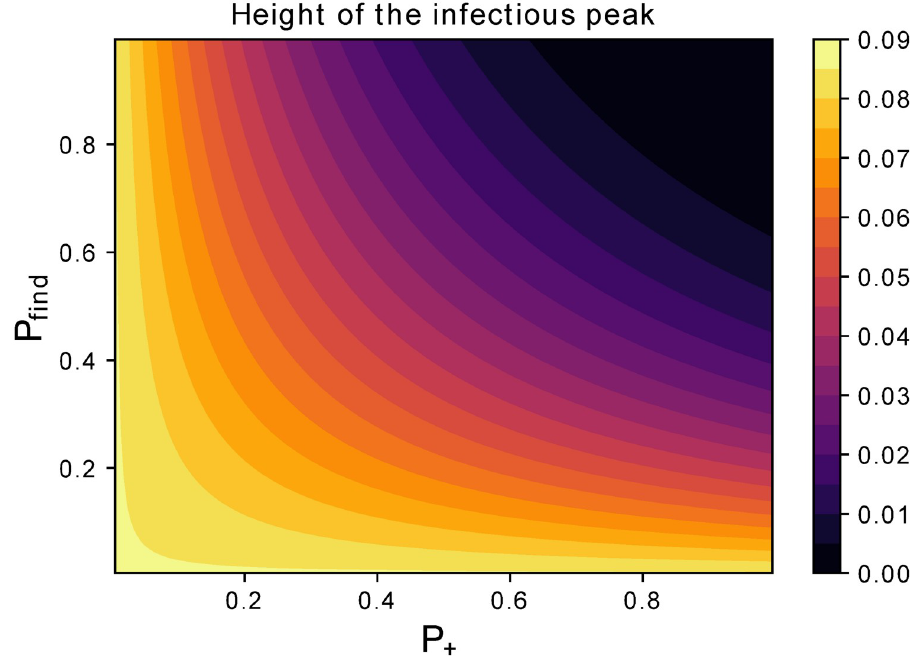
Fig 6. Dependence of latent carriers quarantining on control parameters. Assessing the impact of P the peak of infectious separately. This way, we separate the contribution of those factors to look at resources needed from different fields, e.g. network engineering or wet lab biology. Solutions to boost the testing capacity like [47] could impact both terms.